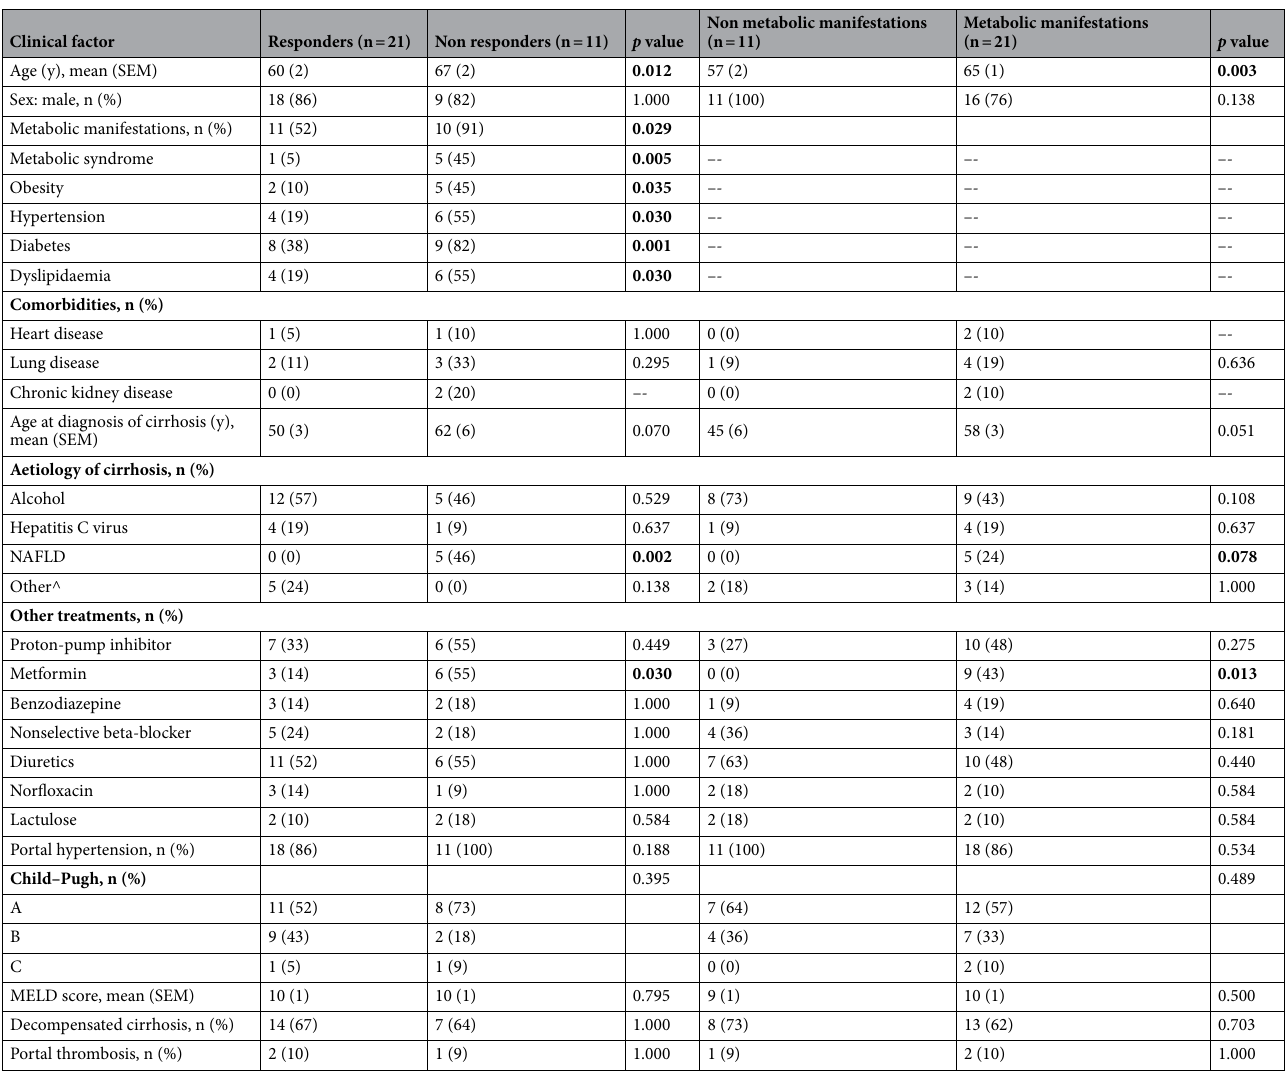
Table 2. Clinical factors according to rifaximin response and metabolic syndrome manifestations. ^ Hepatitis B virus, primary biliary cholangitis, autoimmune, hemochromatosis or cryptogenic cirrhosis. Abbreviations: y: years; SEM: standard error of the mean; M/F: male/female; NAFLD: non-alcoholic fatty liver disease. Significance values are